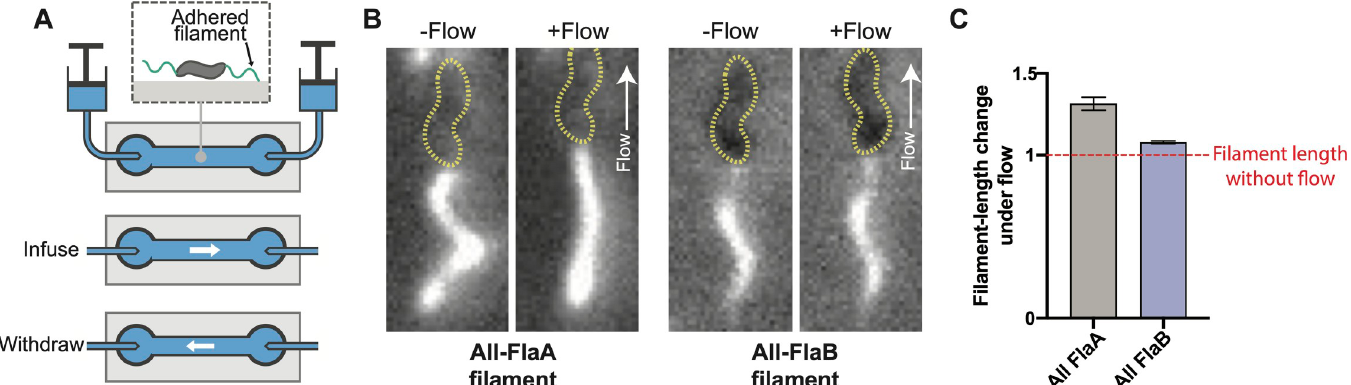
Fig 5. FlaB forms a more rigid filament than FlaA. To determine whether the FlaA portion of the filament is less rigid than the FlaB portion, a flow chamber was constructed that allowed us to flow buffer over labeled, immobilized cells ( A ). When buffer was flowed past WT ( i . e . flaA S397C flaB + ) or all-FlaA filaments, they stretched to become ~30% longer than their relaxed length. In contrast, all-FlaB filaments stretched only ~10% under the same flow conditions ( B and C ). For C , 16 all-FlaA filaments and 20 all-FlaB filaments were measured for elongation under flow, error bars represent the SEM for each.